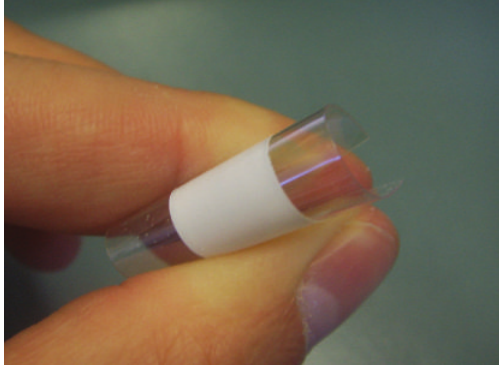
Figure 1: A Photo of a high-quality TiO 2 film produced by the CIP technique for flexible DSCs.